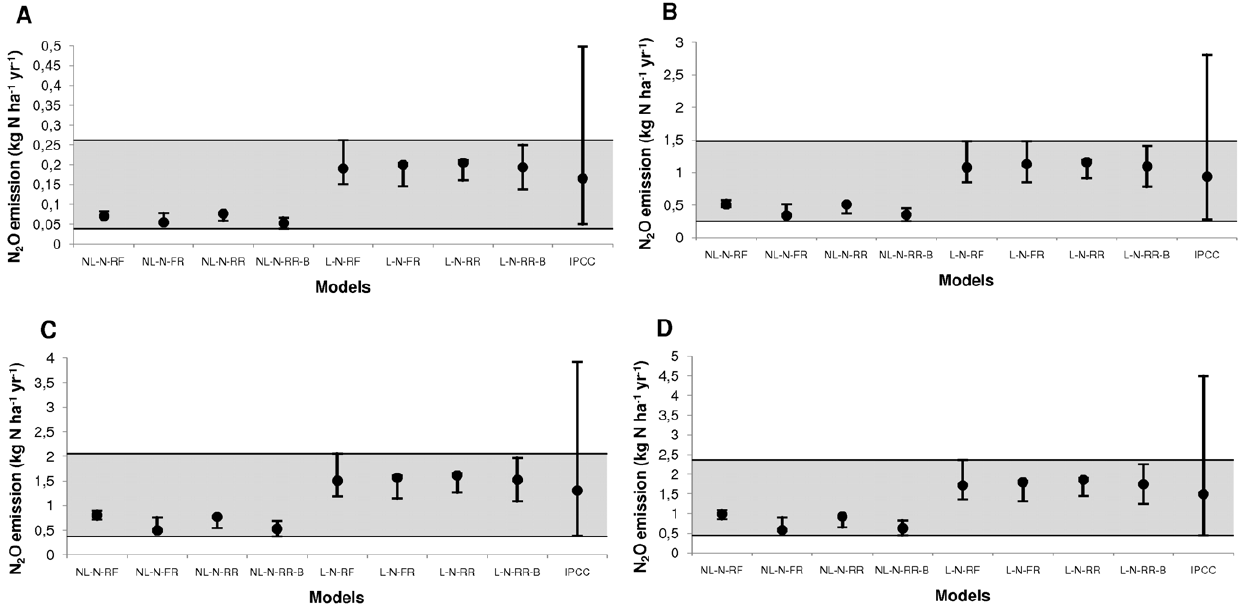
Figure 4. Predicted N 2 O emissions due to N fertilization and 95% confidence intervals (CI) for each model, and predicted values and uncertainty ranges for the IPCC-Tier 1 method. The light gray area corresponds to the values covered by the 95% CI of our eight models. The amounts of N applied were A) 16.62 kg N ha 2 1 , B) 93.6 kg N ha 2 1 , C) 130.74 kg N ha 2 1 , D) 149.58 kg N ha 2 1 (average amounts of applied N for western, eastern and southern Africa, worldwide, Europe, and eastern Asia respectively). N 2 O emissions were estimated by subtracting the value corresponding to the application of no N from the value for each amount of N applied.